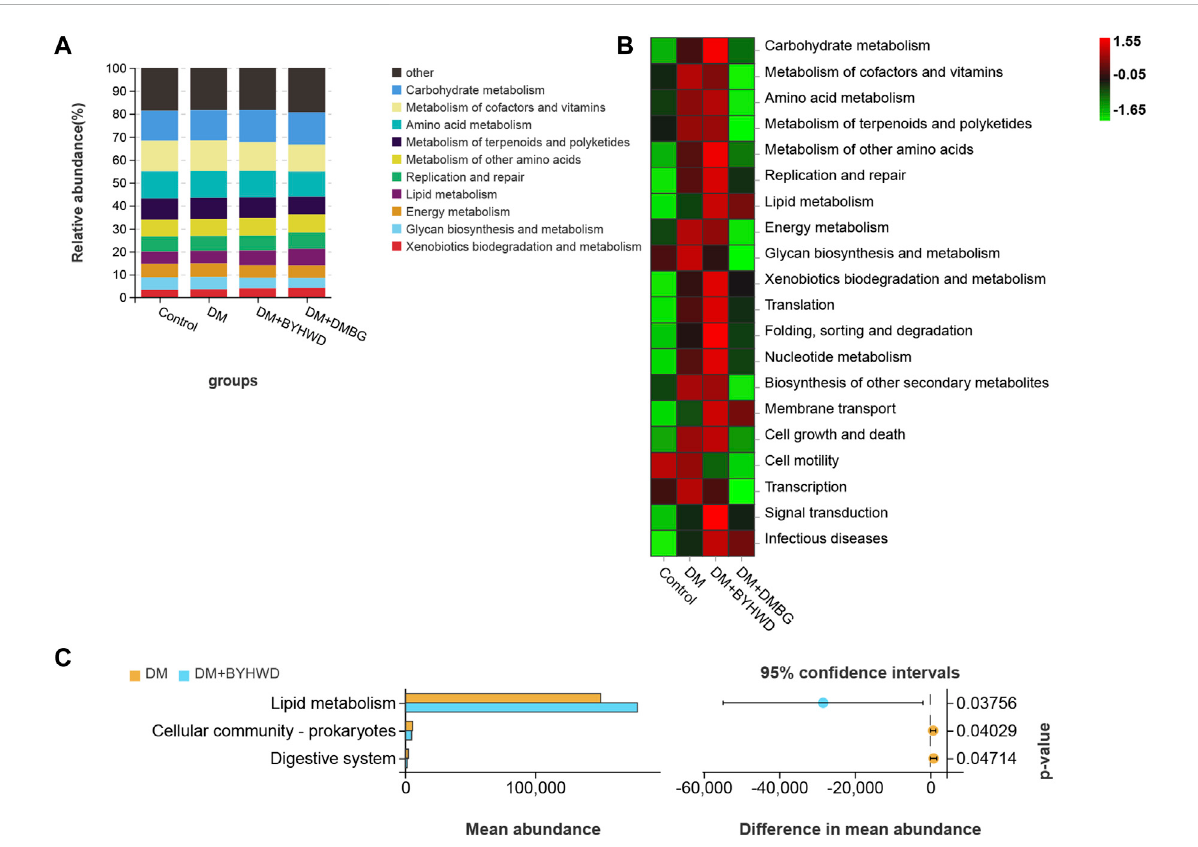
FIGURE 7 © The effect of BYHWD treatment on the composition and diversity of the gut fl ora: (A) bacterial beta-diversity among the four groups was accessed byPCA, PCoA,and NMDS; (B) theclusterdendrogramofall samples basedontheweightUniFracdistanceandcomparisonofeach group; (C) the cluster dendrogram of all samples based on the unweight UniFrac distance and comparison of each group. Data are shown as means ± S.D ( n = 6 – 8). Statistical analysis was performed by using one-way ANOVA, followed by Tukey ’ s multiple comparisons test for the false discovery rate. * p < 0.05 was set to compare the mean of each group with the mean of the DM